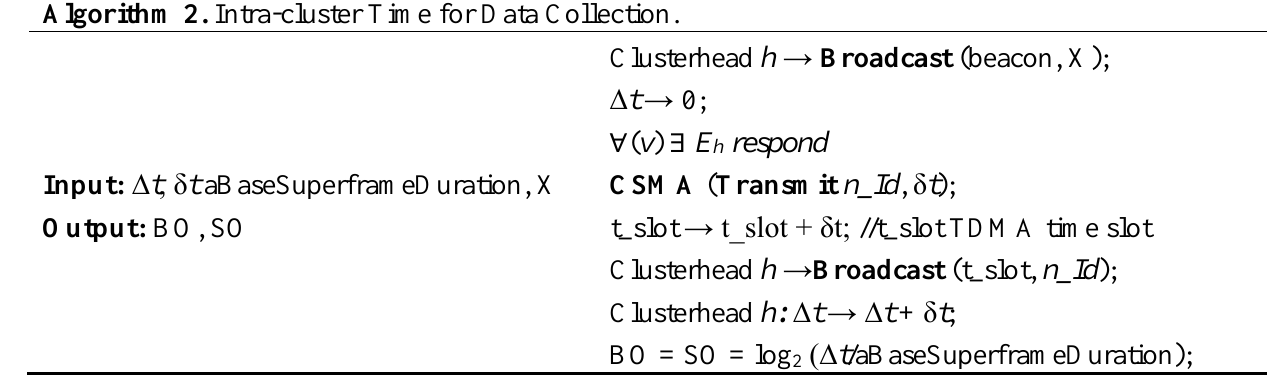
Table 2. Computing beacon order (BO) and superframe order (SO) based on Time ∆ t and δ t . Algorithm 2. Intra-cluster Time for Data